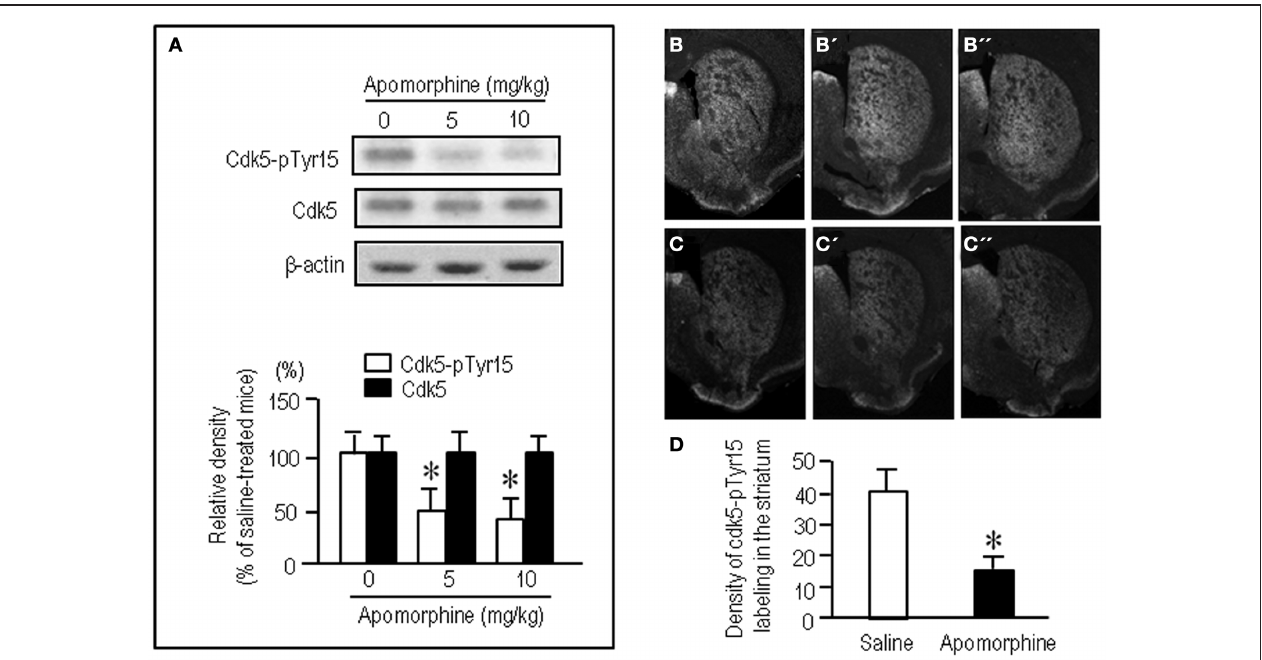
FIGURE 2 | Dopamine receptor stimulation inhibits striatal phosphorylation of Cdk5 at Tyr15. (A) Western blot analysis on the effects of apomorphine on striatal levels of Cdk5-pTyr15. Mice received saline or the indicated amounts of apomorphine 30min before sacrifice. Values are means ± S.E.M. ( n = 5). ∗ P < 0 . 005 versus saline-treated mice; two tailed Student’s t -test. (B–D) Immunohistochemical assessment of the effects of apomorphine on striatal density of Cdk5-pTyr15 labeling. (B–B”) Frontal sections stained for Cdk5-pTyr15 in the anterior ( B ; 1.3mm anterior to bregma), middle ( B’ ; 1.0mm